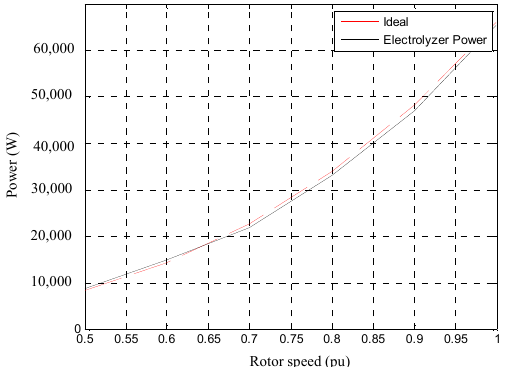
Figure 4. Power versus rotor speed.